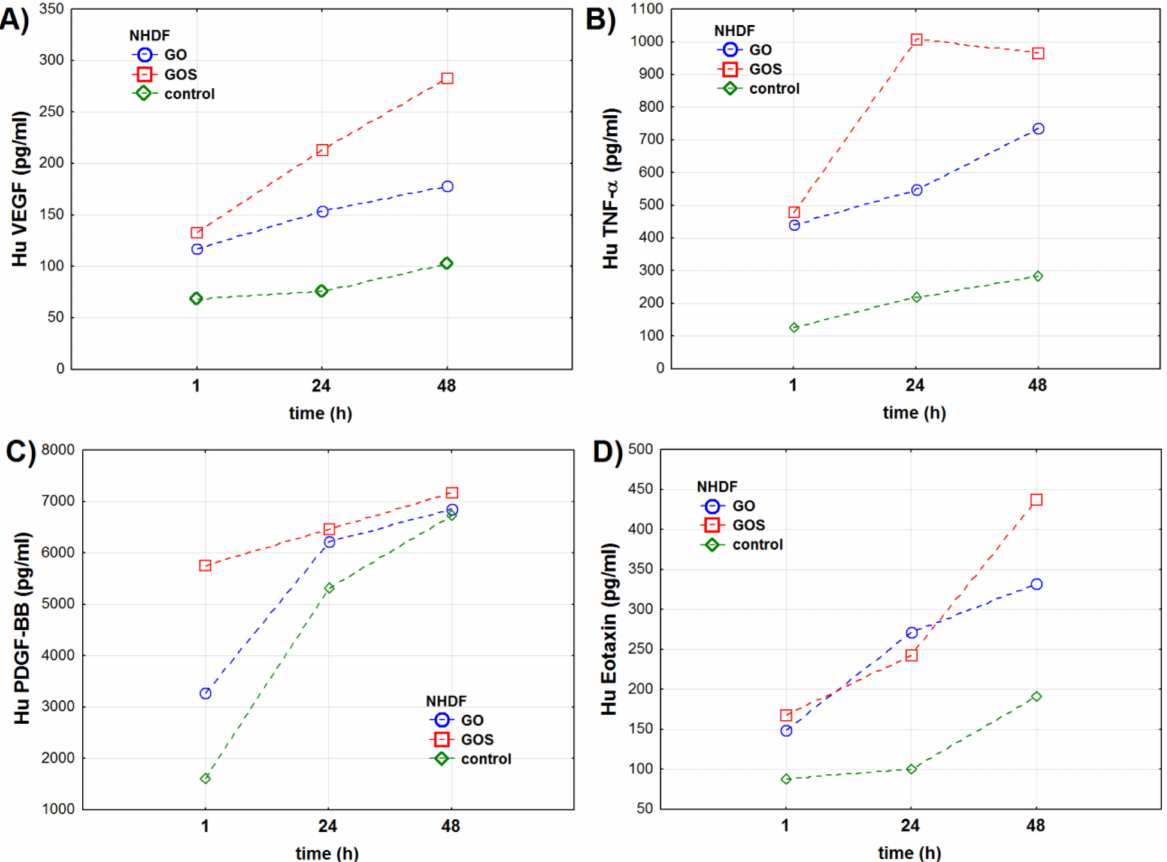
Figure 3. Cytokines’ concentrations (pg/mL) in the NHDF (normal human dermal fibroblasts) cell line measured 1, 24, and 48 h after exposure to ultrapure (GO) or manganese ions-contaminated graphene oxide (GOS): ( A ) vascular endothelial growing factor (VEGF), ( B ) tumor necrosis factor-alpha (TNF- α ), ( C ) platelet-derived growth factor-BB (PDGF- BB), ( D ) eotaxin. The markers present mean value of the analyzed